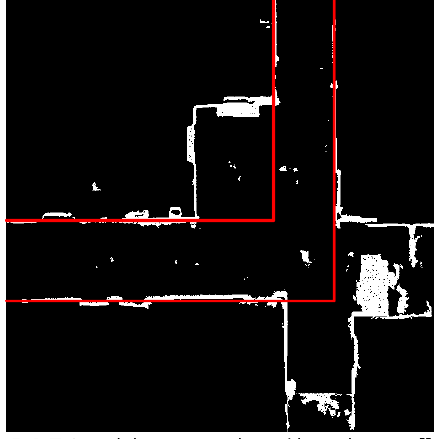
Figure 5. BIPC and the extracted corridor, where walls are in white and the corridor is in red.